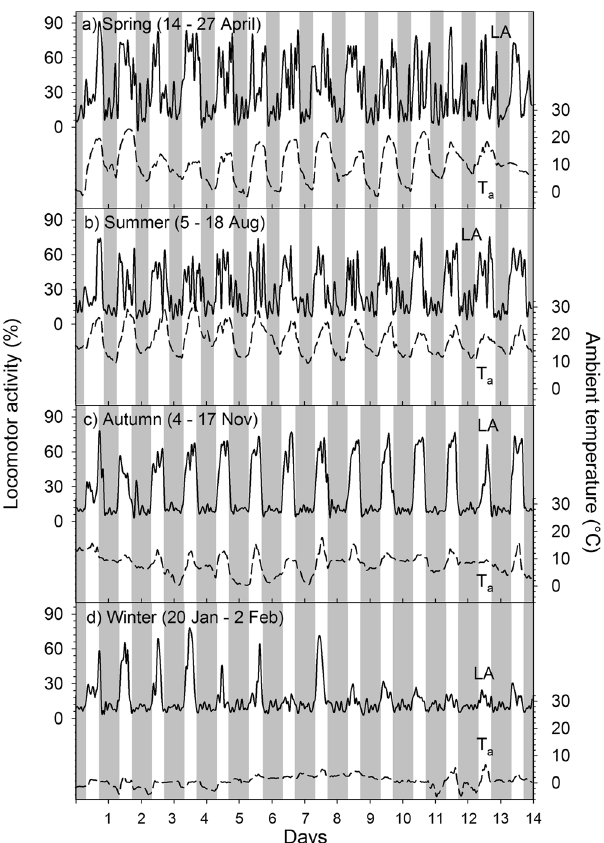
Figure 5. Locomotor activity in llamas. Data show the diurnal rhythm of ambient temperature (T a , dashed line) and mean daily locomotor activity (LA, solid line) in adult non-pregnant llama dams (N = 7) during two weeks in four different seasons (spring, summer, autumn, winter) under central European climatic conditions. Grey shaded areas indicate night-phase. Axis range for LA and T a is the same for each